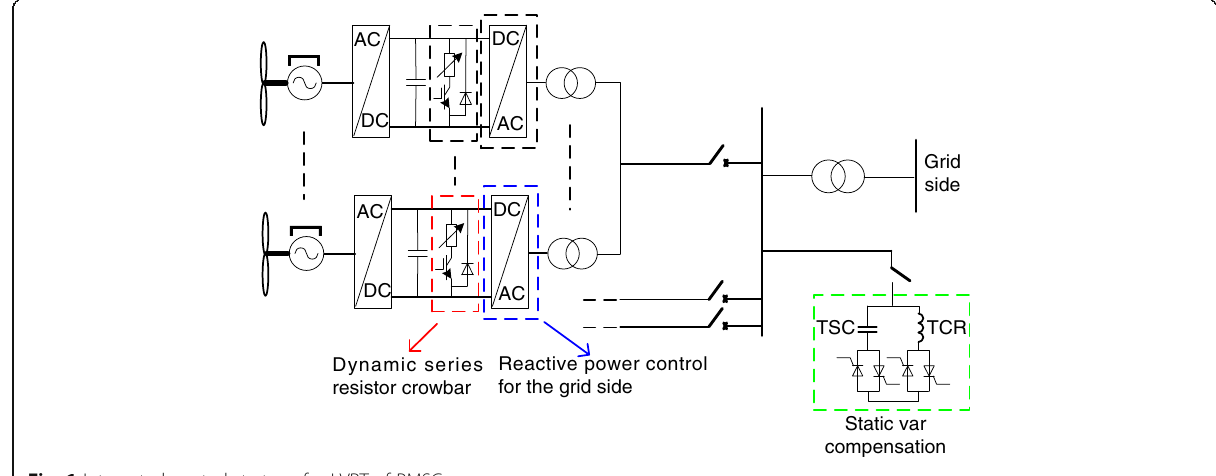
Fig. 1 Integrated control strategy for LVRT of PMSG